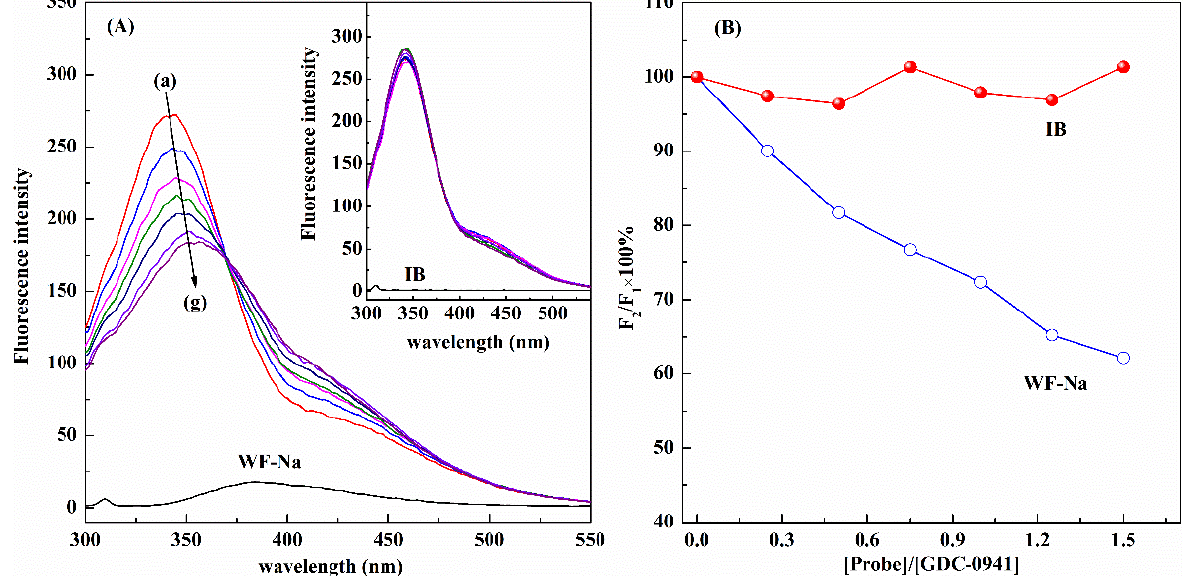
Figure 7. ( A ) Effect of WF-Na and IB on the fluorescence intensity of the HSA–GDC-0941 system ( C HSA = 2 μ M, C GDC-0941 = 3 μ M), λ ex = 280 nm, pH = 7.4, T = 298 K. ( B ) The plot of values against the